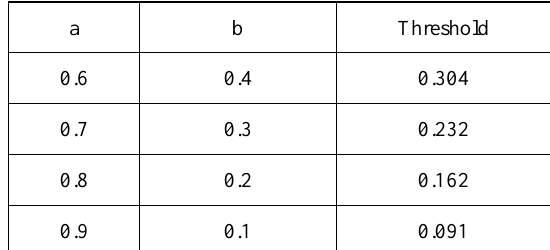
Table 3. Weight distribution and the size of the corresponding threshold